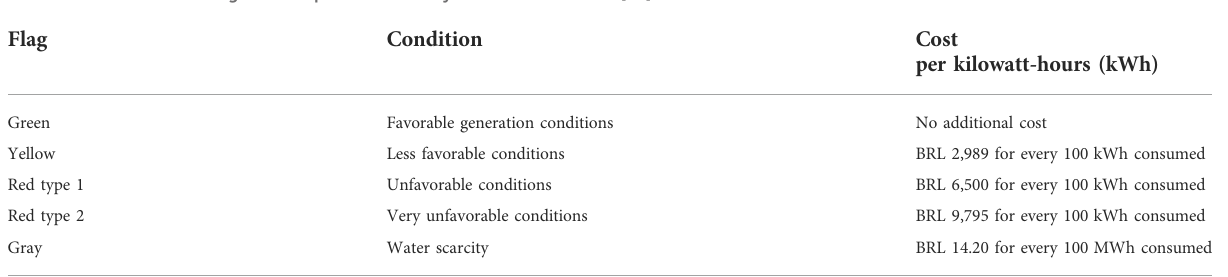
FIGURE 10 Quantitative representation in months of the activation of tariff fl ags in the period from January 2015 to July 2022 (ANEEL).